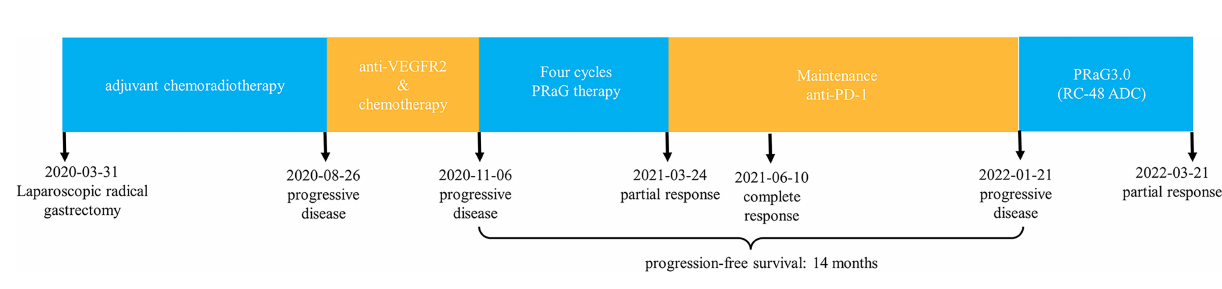
FIGURE 2 | Timeline of the whole treatment process for the patient. The patient experienced PD with the new emergence of enlarged paratracheal lymph nodes during postoperative adjuvant chemotherapy on 26 August 2020. Two months after apatinib was combined with chemotherapy, the subcarinal LN, right upper paratracheal LN, and left lower paratracheal LN were detected by CT scan on 06 November 2020, and the patient developed PI) again, After 4 cycles of PRaG therapy, the sum of diameters of the unirradiated target metastases decreased by 45% from baseline, and the right upper paratracheal LN almost disappeared. The patient was assessed as PR on 24 March 2021.18F FDG PET-CT on 10 June 2021, most LNs disappeared and one shrunk to normal size with normal FDG uptake. Therefore the patient achieved CR. Although the patient unfortunately suffered PD again on 21 January 2022 (new metastatic LNs appeared), he obtained 14 months of PFS from the start of PRaG therapy on 19 November 2020. PRaG therapy: The patient was treated with subcutaneous GM-CSF (200 gg once daily, d4-17) after the completion of radiotherapy (15Gy/3f, d1-3) and received a PD-I inhibitor (toripalimab 240mg, d4.The PRaG regimen was repeated every three weeks, and different mediastinal lymph nodes were irradiated during the PRaG treatment, with each cycle delivered to one metastatic site. After four cycles of PRaG therapy, maintenance treatment ofPD-1 monotherapy was administered every three weeks. Until 21 January 2022, when the patient suffered PD again, Each cycle of the above has a duration of 21 days. LN, lymph node; PD, progressive disease; PR, partial response; CR, complete response; PFS, progression-free survival.